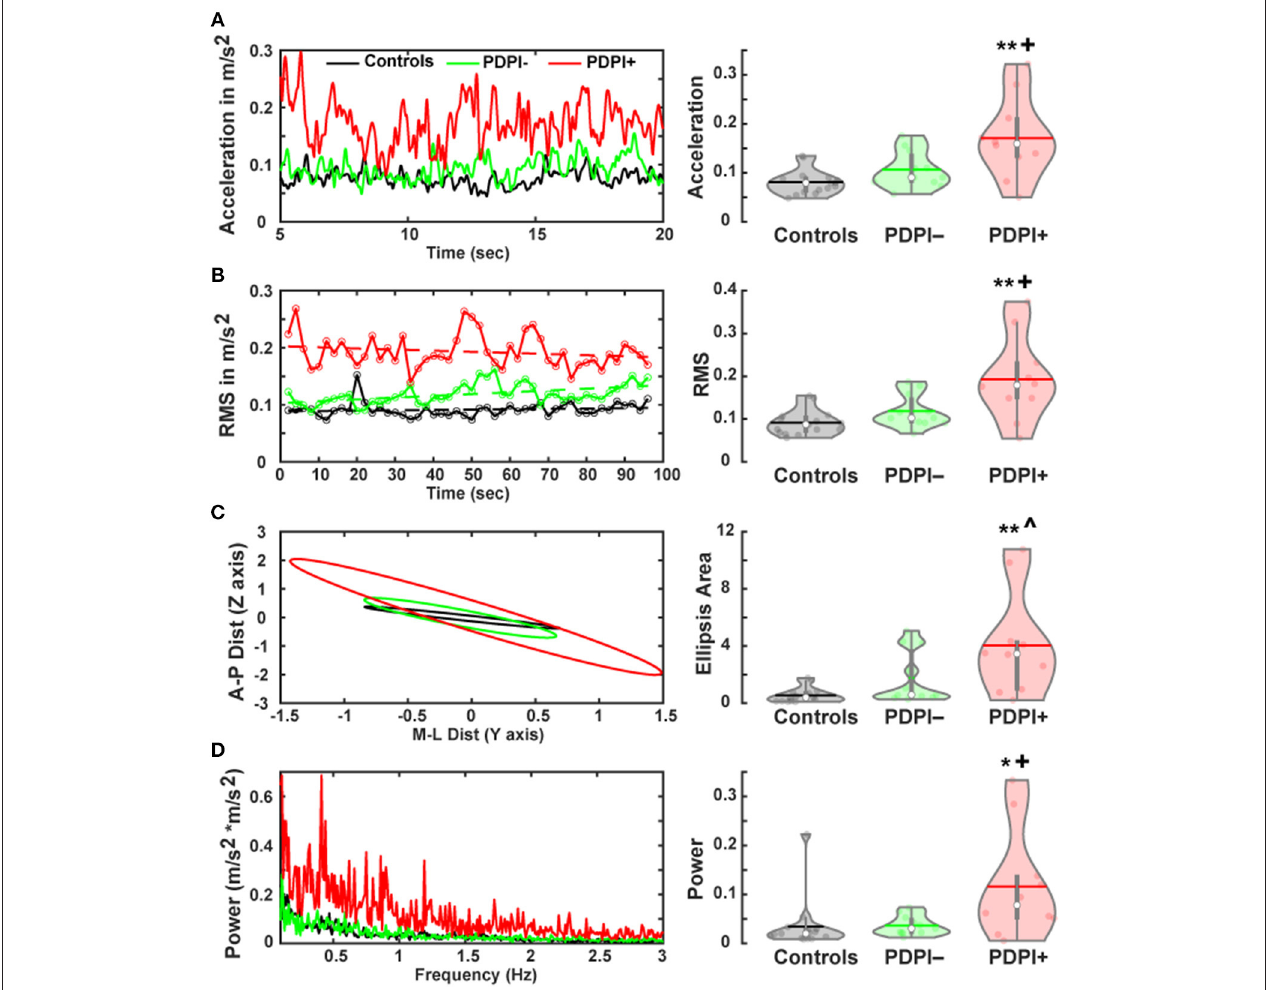
FIGURE 1 | Parkinson’s disease patients with postural instability (PDPI + ) show multiple balance deficits during a postural control task. (A) Accelerometer signals of PDPI + demonstrate increased mean acceleration computed through Euclidean mean signals (anteroposterior and mediolateral signals) and (B) increased magnitude of acceleration computed through the root mean square (RMS) of acceleration. (C) PDPI + patients display increased limits of stability as indicated by area of the ellipsis computed using mean anteroposterior and mediolateral movement distances. (D) PDPI + patients have increased mean spectral power of acceleration across the 0.1–3Hz frequency band. ** p < 0.01 vs. controls, * p < 0.05 vs. controls, + p < 0.05 vs. PDPI–, ∧ p < 0.06 vs. PDPI–. The horizontal lines and white circles in the violin plots represent the mean and median values,